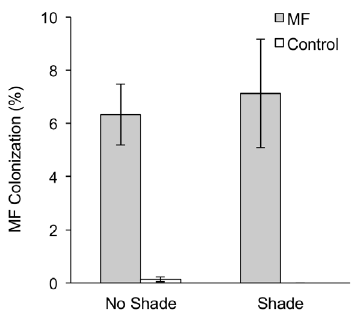
Fig. 1: Percent mycorrhizal colonization. MF = Mycorrhizal Fungi; Values shown are means + SE; n = 15 plants per